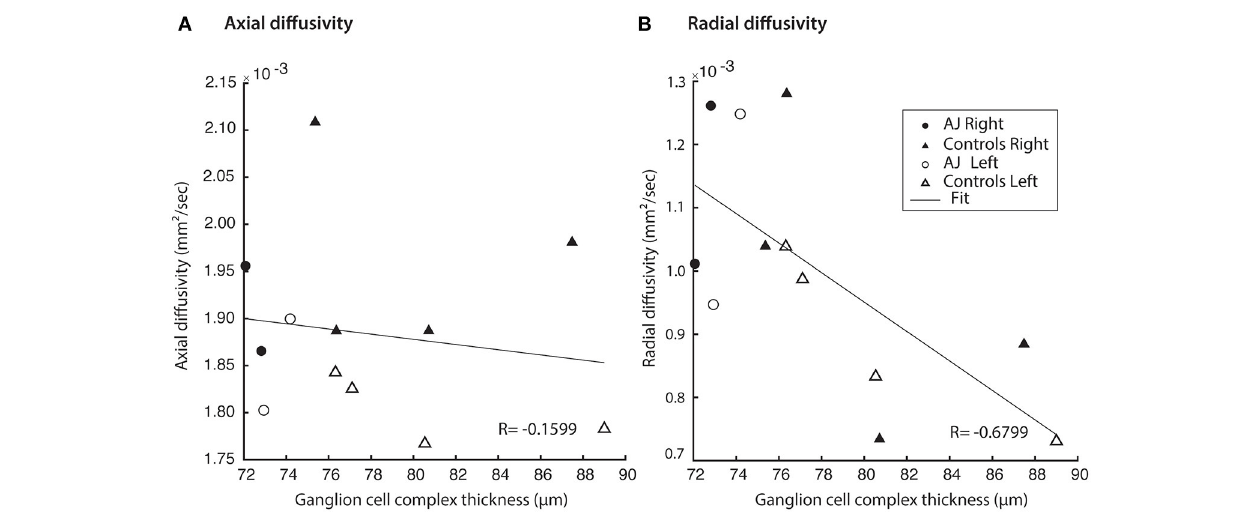
FIGURE 6 | Hemifield GCC thickness measurements are related to indexed diffusion MRI metrics within the corresponding optic tracts. (A) No correlation was identified between GCC and AD ( r = − 0.0235, p = 0.937). All relations evaluated using linear regression. (B) Significant correlations were identified between GCC and RD ( r = − 0.595, p = 0.0247).